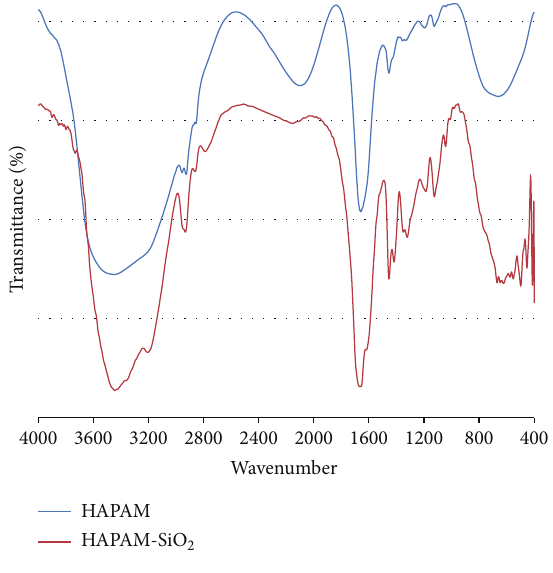
Figure 4: FTIR of HAPAM and HAPAM-SiO 2 .